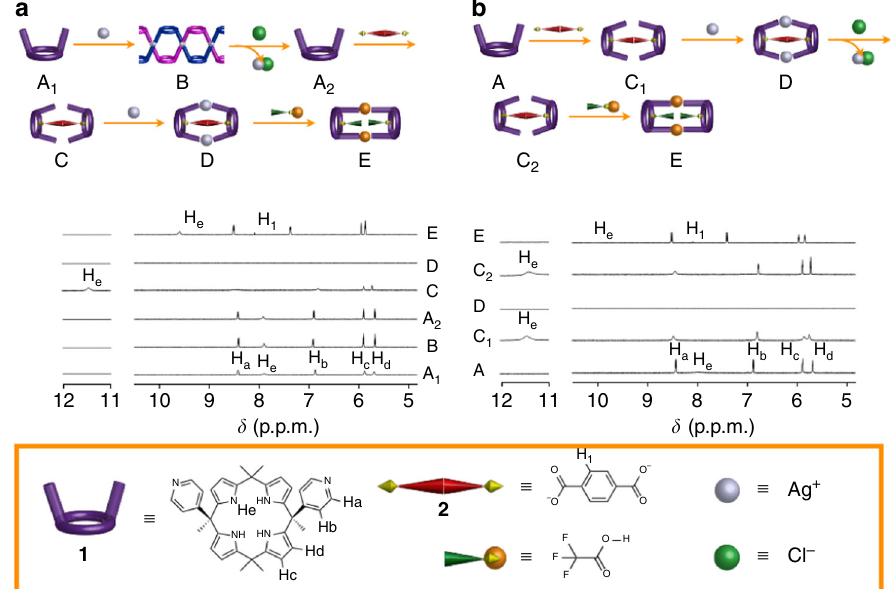
Fig. 4 Schematic illustrations of the transformations between states. a Route 1 (A 1 → B → A 2 → C → D → E). b Route 2 (A → C 1 → D → C 2 → E). The corresponding 1 H NMR spectral changes of 1 (2.0 × 10 − 3 mol l − 1 ) were recorded in MeCN- d